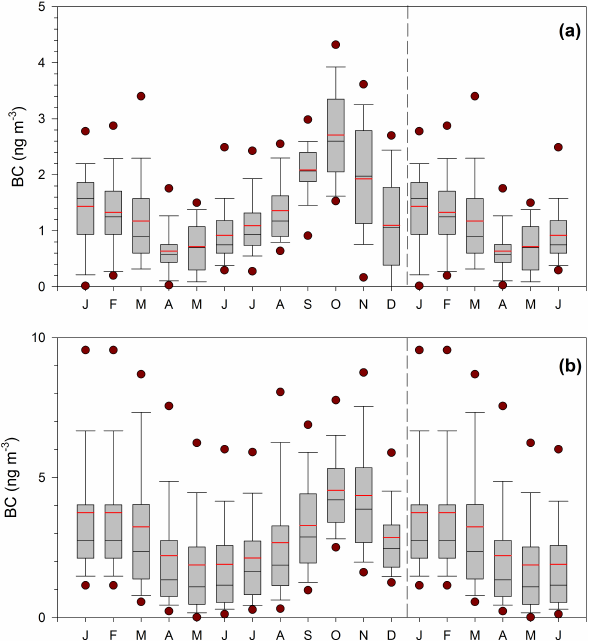
Fig. 4. Box plots of the mean seasonality of BC concentrations based on daily medians: Results measured by the AE10 for the years 1999–2009 (a) and by the MAAP for the period 2006–2011. Lines in the middle of the boxes represent sample medians (mean: red line), lower and upper lines of the boxes are the 25th and 75th per- centiles, whiskers indicate the 10th and 90th percentiles, dots 5th and 95th percentiles. The graph comprises 18 months starting from January to show the summer maximum without